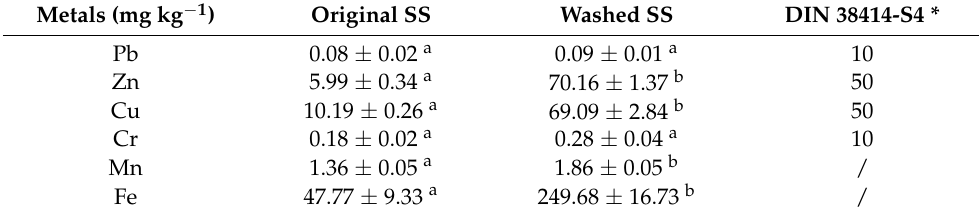
Table 3. Leaching of metals from original and washed sewage sludge (SS). Data are given as average ± standard error of three subsamples taken from the homogenized bulk of original SS and from a combined sample of washed SS from batches one–five. Different letters indicate significant differences between treatments according to Duncan’s test ( p <